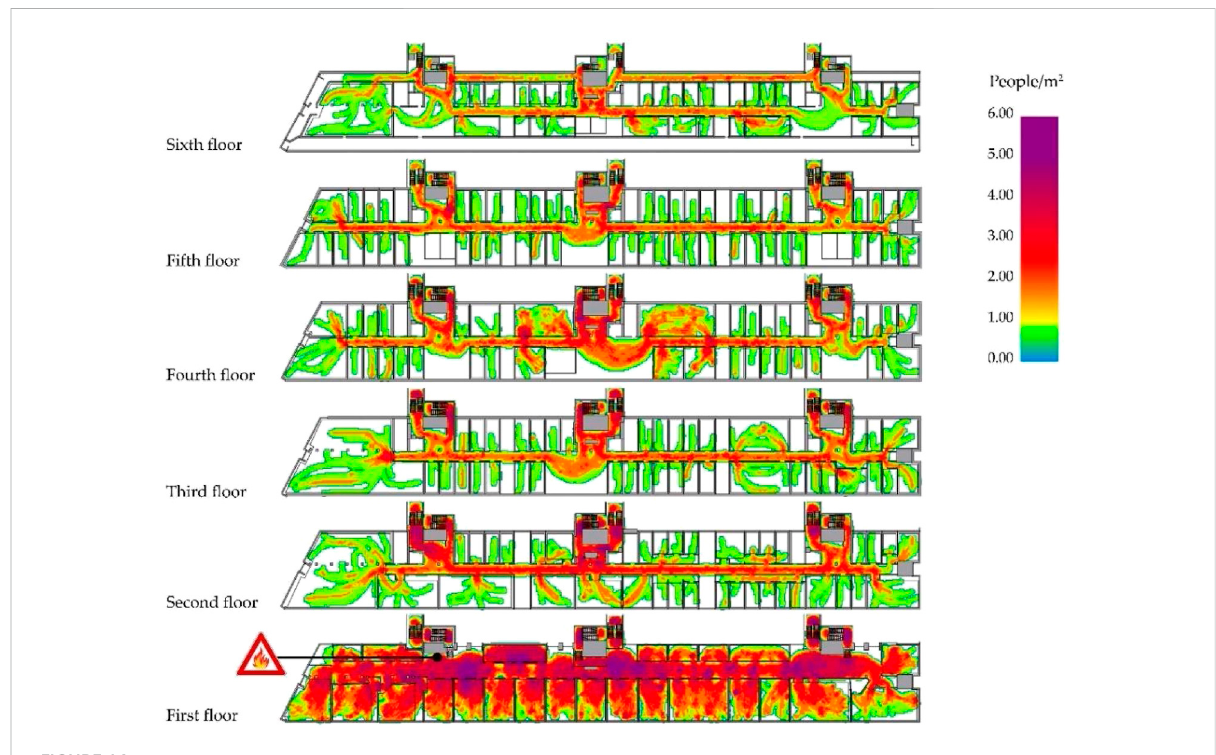
FIGURE 14 Density maps of crowd simulation of the second